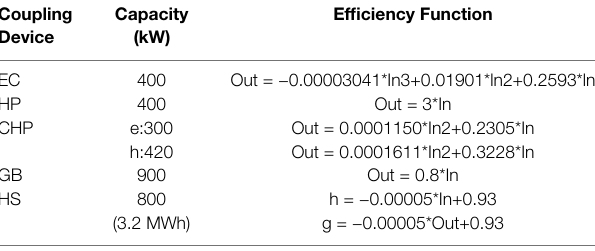
TABLE 1 | Parameters of the energy coupling equipment.